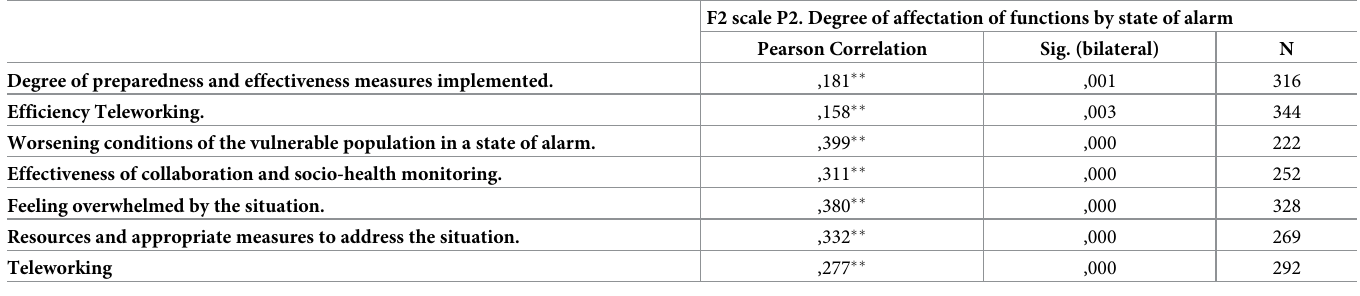
Table 4. Correlations between the degree to which the functions are affected by the state of alarm and the rest of the factors.